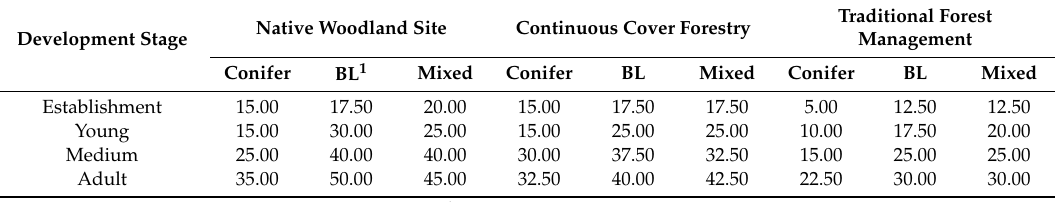
Table 5. Recreational subsidy provided to private forest owners on a € ha − 1 yr − 1 basis (i.e., it depends on the forest type and development stage of the forest).